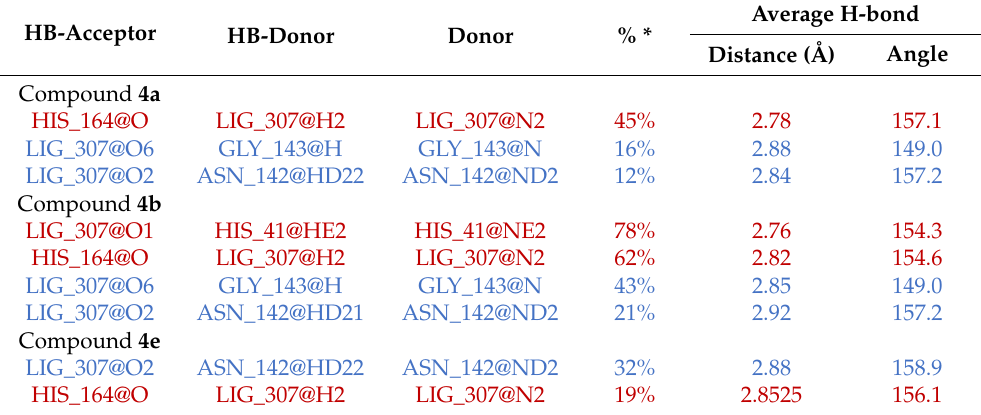
Table 1. Analysis of the H-bond interactions throughout the 80 ns MD trajectory of compounds 4a , 4b and 4e , displaying only H-bonds that were maintained in more than 10% of the trajectory snapshots. For each H-bond, column 1 represents the acceptor residue and atom name. Columns 2 and 3 indicate the name of the H-atom and the electronegative atom attached to it on the donor residue, respectively. Interactions with residues of S1 and S2 subsites are shown in blue and red, respectively.